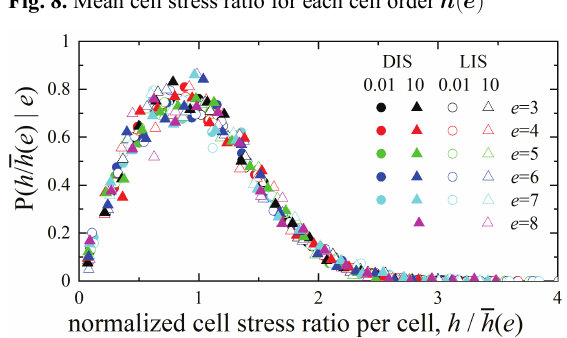
Fig. 8. Mean cell stress ratio for each cell order